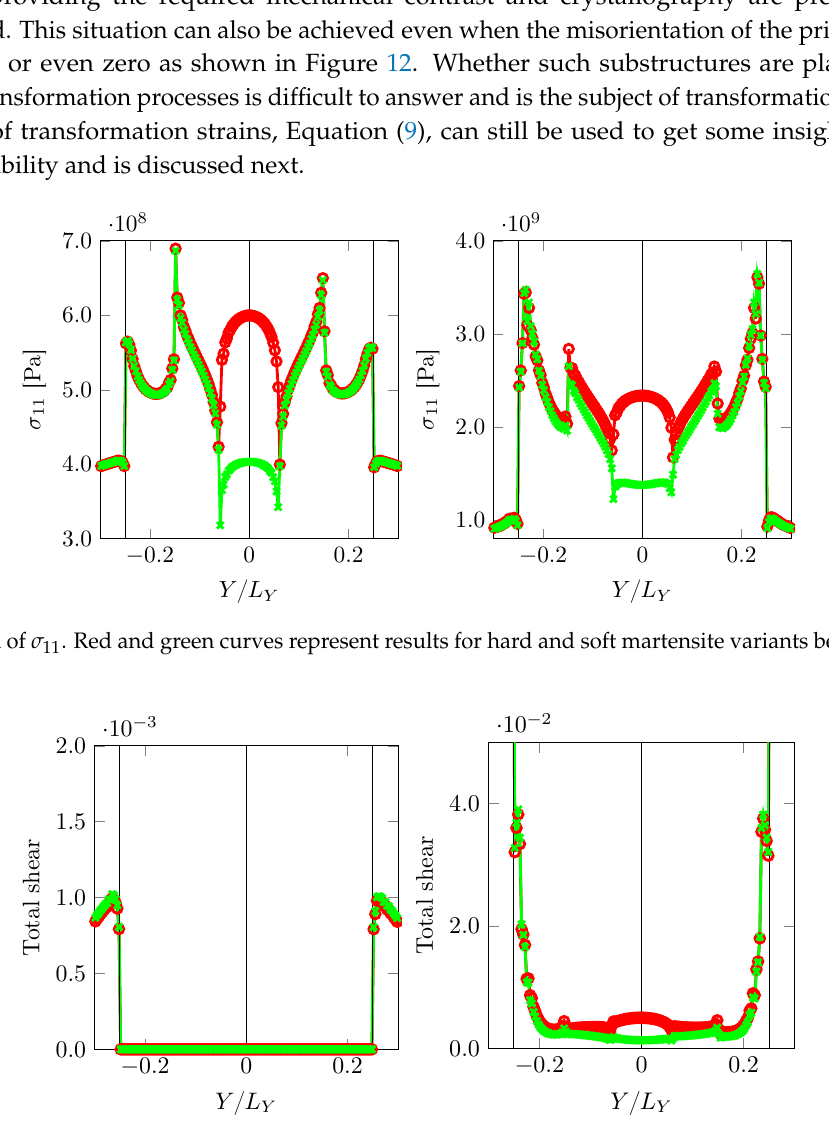
( b ) Distribution of total shear . Red and green curves represent results for hard and soft martensite variants T between O 1 O 2 , respectively. L X /2 N X close to zero misorientation Figure 12. σ 11 and total shear distribution along path X = T − PAGB (separating prior austenite and ) at two different overall deformation levels, ¯ F 11 = 1.00125 A 1 A 1 ( left column) and ¯ F 11 = 1.00875 ( right